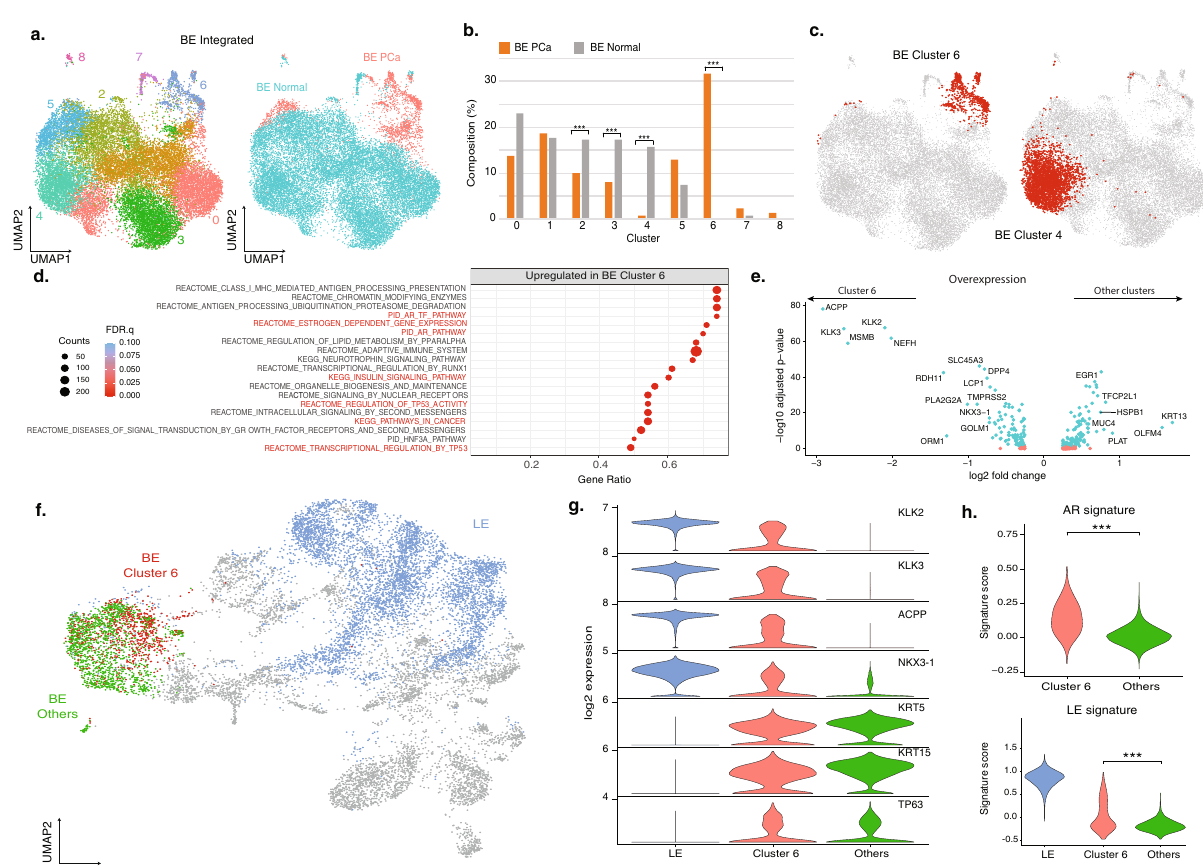
Fig. 4 Integration of BE and LE cells identi fi es tumor-associated cell states enriched in the PCa samples. a UMAP of integrated BE cells labeled by cell states (left) or samples type (BE PCa and BE Normal) (right). b Cell composition comparison between BE PCa and BE Normal (*** P < 0.001, two-sided Fisher ’ s exact test; cluster 2: P = 1.24e-19; cluster 3: P = 2.00e-31; cluster 4: P = 9.31e-122; cluster 6: P < 2.2e-16). c PCa and normal enriched cell states 4 and 6 highlighted in the integrated BE UMAP. d Top 20 upregulated signaling pathways between cluster 6 and the other BE on C2 canonical gene set (C2CP) collection ( N = 2,332). Gene counts for the corresponding gene set are indicated by marker radius. Statistical signi fi cance levels (FDR) are shown by the color gradient. Pathways associated with PCa tumor progression and invasiveness are highlighted in red. e Volcano plots of the overexpressed genes in BE cluster 6 and other BE cell states within the PCa samples. f Distribution of BE cluster 6, other BE and LE on the overall epithelial cell UMAP. g Violin plot comparison between BE cluster 6, other BE and LE for multiple LE and BE markers within the PCa samples. h Comparison of Hallmark AR pathway signature and LE signature scores within the PCa samples (*** P < 0.001, Wilcoxon rank-sum test; Hallmark AR pathway signature: P = 2.10e-111;